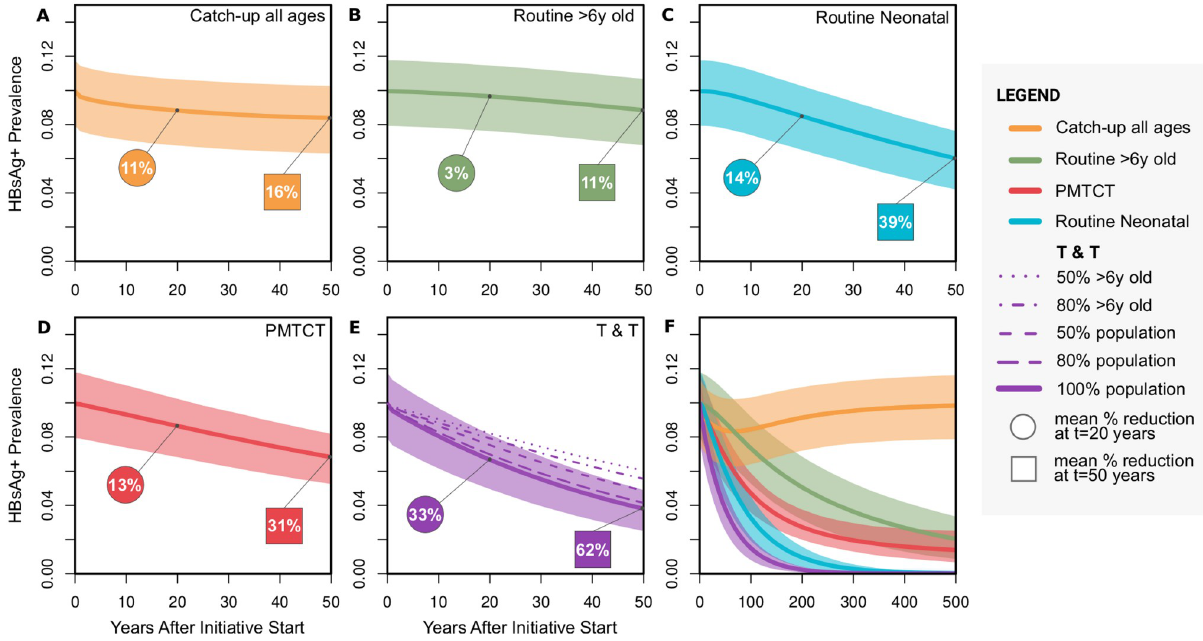
Fig 6. Decline in HBsAg prevalence over time in response to population interventions for HBV infection in Uganda. Decline in prevalence is shown over time starting at approximately 10% as used for model fitting to the Uganda setting (see main text). Shaded areas show 95% confidence interval for each intervention based on 5,000 stochastic simulations using parameter samples from the posteriors obtained by fitting the model. Comparisons of interventions applied to 100% of the population: (A) catch-up vaccination of all ages as a one-off event at time = 0 (orange); (B) routine immunisation of children as they reach 6 years of age (proxy for school age) (green); (C) routine neonatal immunisation (blue); and (D) PMTCT interventions for all births (combining accelerated neonatal immunisation with HBIg and antiviral therapy in pregnant mothers, red). (E) Comparison of a T&T approach applied to different proportions of the population: 50% of individuals older than 6 years, 80% of individuals older than 6 years, 50% of population, 80% of population, and 100% of population (purple solid line). This demonstrates the impact of reduced proportions of the population exposed to drug therapy, as a result of either not having drug prescribed or noncompliance with prescribed therapy. (F) Interventions shown in A–E applied to 100% of the population were run for an extended time period of 500 years to observe long-term effects. The numbers at time points t = 20 and t = 50 years, incorporating an overall timeframe that includes the 2030 elimination targets, show the mean reduction in HBsAg prevalence achieved for each of the interventions: (A) 11% (95% CI 9%–15%) and 16% (13%–20%); (B) 3% (2%–5%) and 11% (9%–15%); (C) 14% (12%–18%) and 39% (34%–47%); (D) 13% (10%–15%) and 31% (25%–35%); and (E) 33% (30%–37%) and 62% (57%–68%). HBIg, hepatitis B immunoglobulin; HBsAg, hepatitis B surface antigen; HBV, hepatitis B virus; PMTCT, prevention of mother to child transmission; T&T, Test and